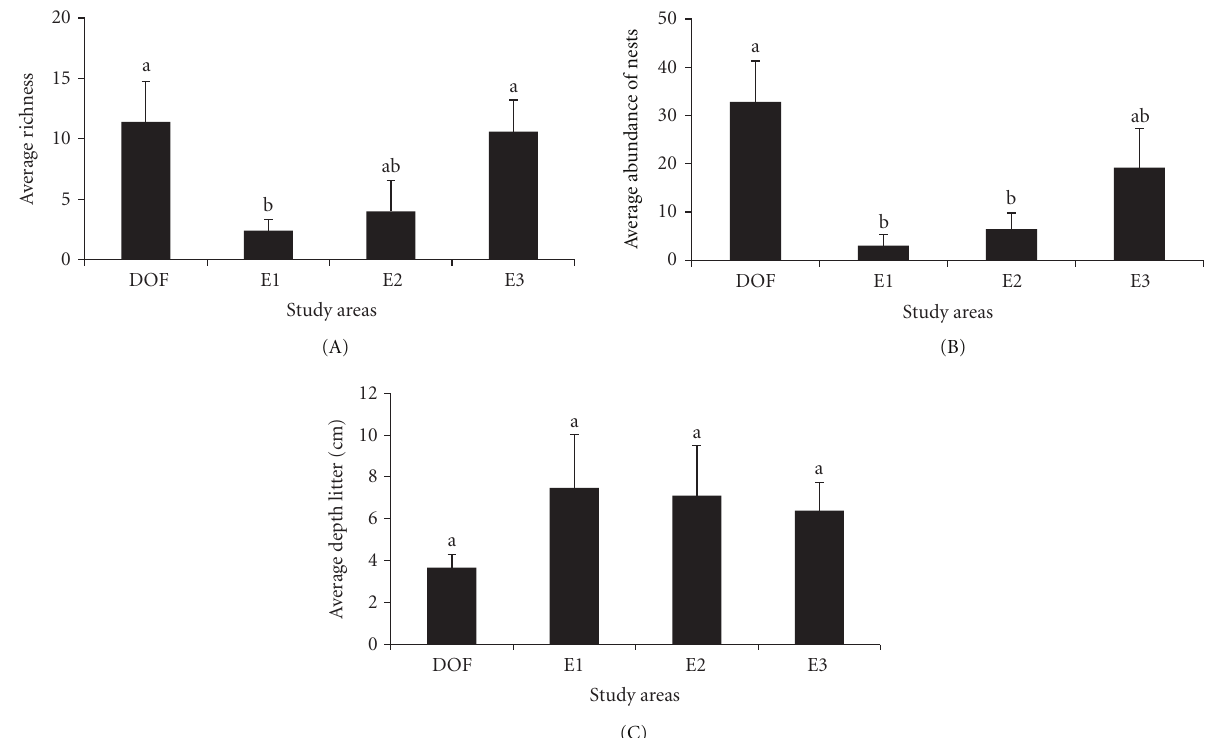
Figure 3: Species richness values (A), mean nest abundance (B), and average depth litter (cm) (C) di ff ered between forest types. DOF: dense ombrophilous forest, E1: commercial plantation managed for 7 years, E2: commercial plantation managed for 28 years, and E3: eucalyptus plantation left unmanaged for 28 years. Vertical bar: standard deviation. Di ff erent letters: P < 0 .